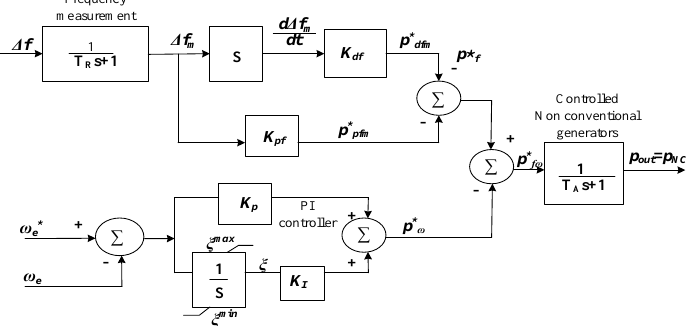
Figure 17. Simplified layout for inertial transient control.